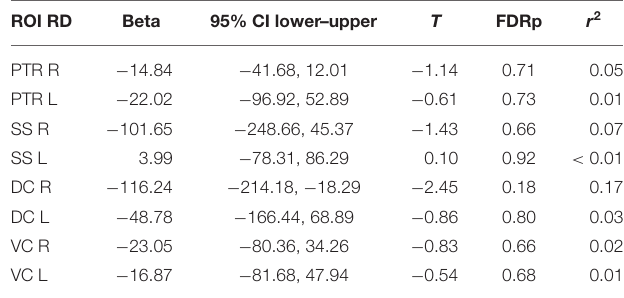
TABLE 4 | Linear regression results for change in mean RD with change in Y-BOCS in the OCD patients ( n =